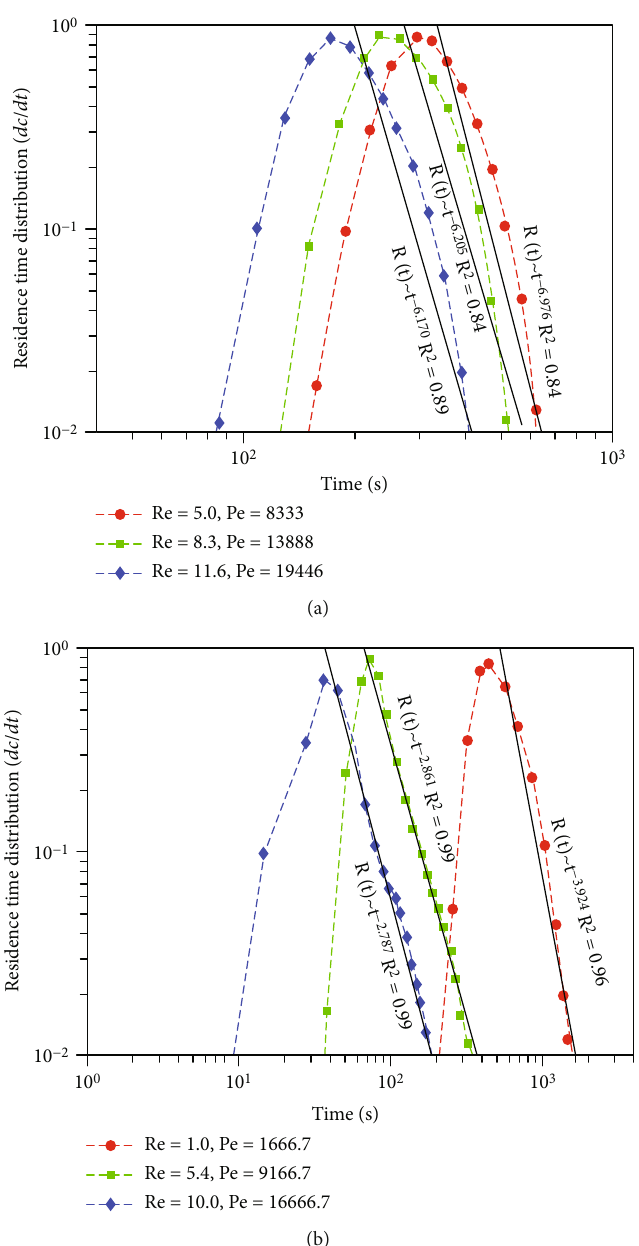
Figure 4: The corresponding RTDs for the single fracture in pattern 1 of group 1 (a) and pattern 1 of group 2 (b) with di ff erent Pe